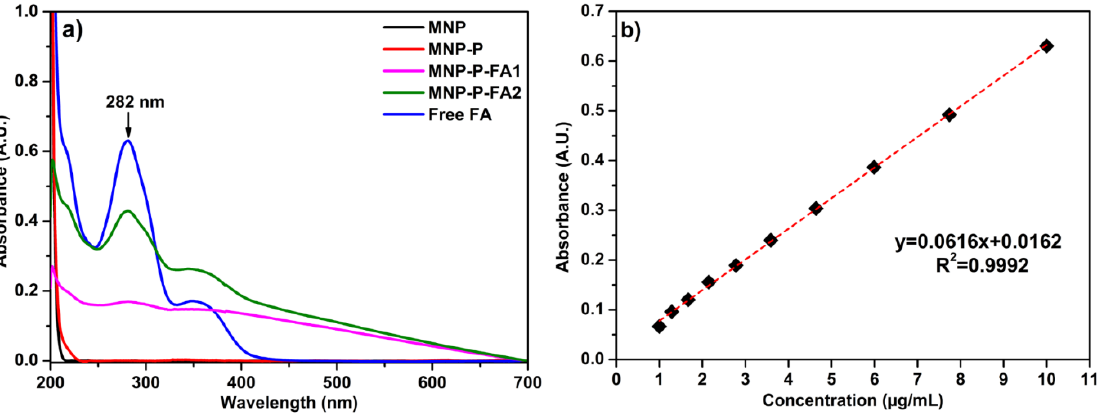
Figure 2. ( a ) UV-Vis spectra of MNP (black), MNP-P (red), MNP-P-FA1 (magenta), MNP-P-FA2 (green), and free FA (blue); ( b ) FA calibration curve at peak 282 nm with concentration 1 ÷ 10 µ g/mL. A.U.—arbitrary units.